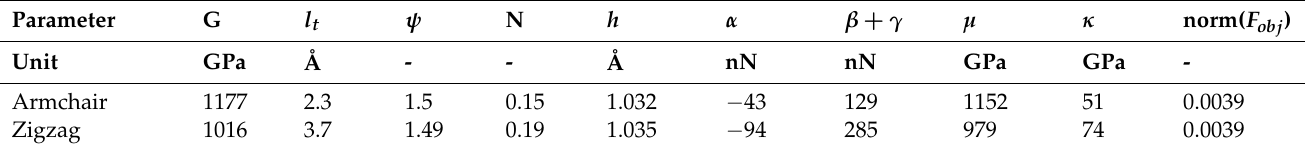
Table 2. Identified material parameters for armchair and zigzag CNTs as micropolar materials.